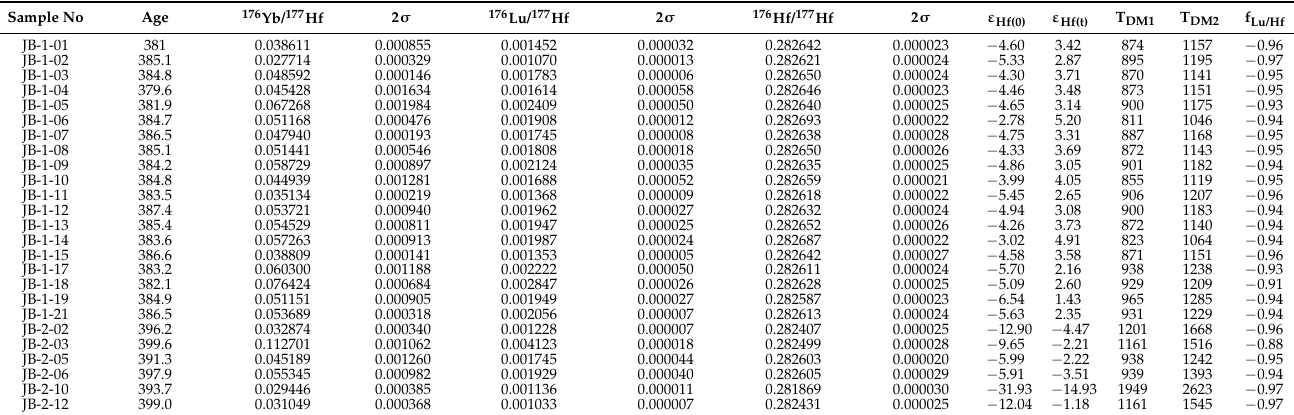
Table 2. Hf isotope data of zircon from granite and diorite dykes of the Jinba gold deposit.